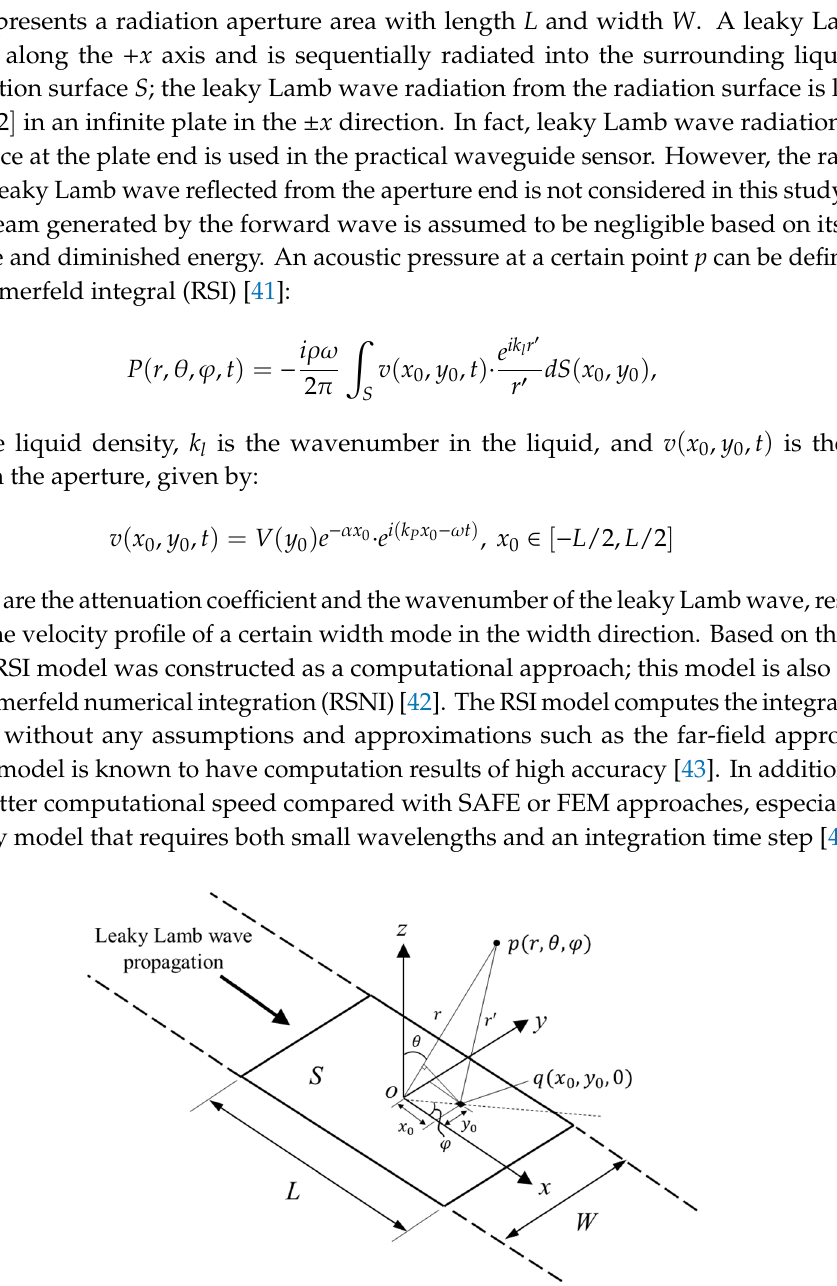
Figure 4. Coordinate system of radiation aperture area for leaky Lamb wave radiation .